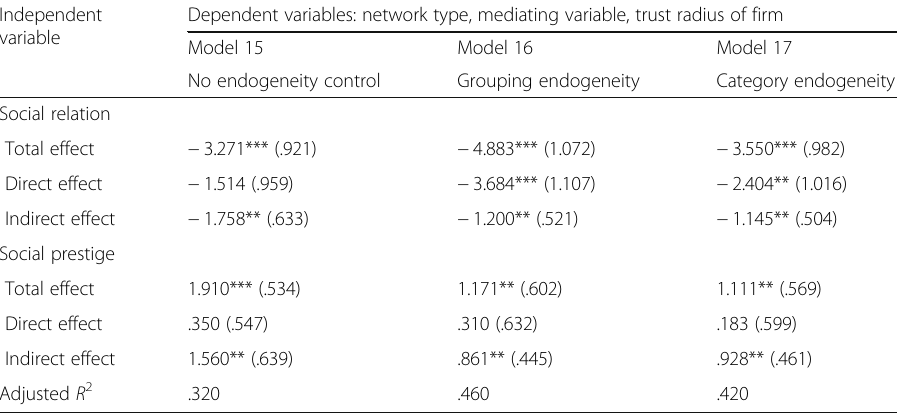
Table 6 KHB analysis of mediating effect N =